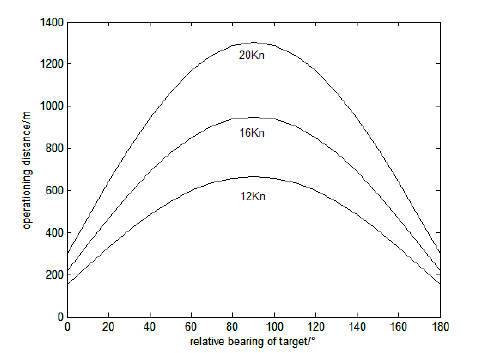
Fig. 3. Operationing distance of passive acoustic homing